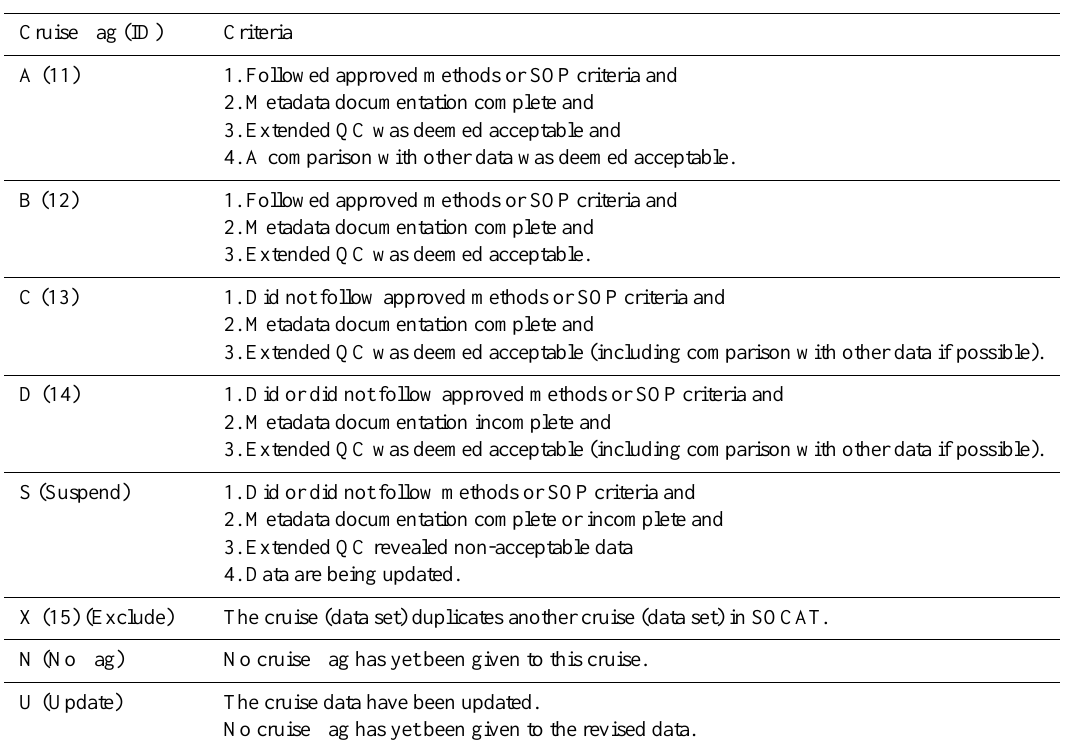
Table 6. Criteria for assigning cruise flags, based on the expected quality of the recommended f CO 2 data (revised after Olsen and Metzl, 2009). All criteria need to be met for assigning a cruise flag. SOP is Standard Operating Procedures (Dickson et al., 2007). QC is quality